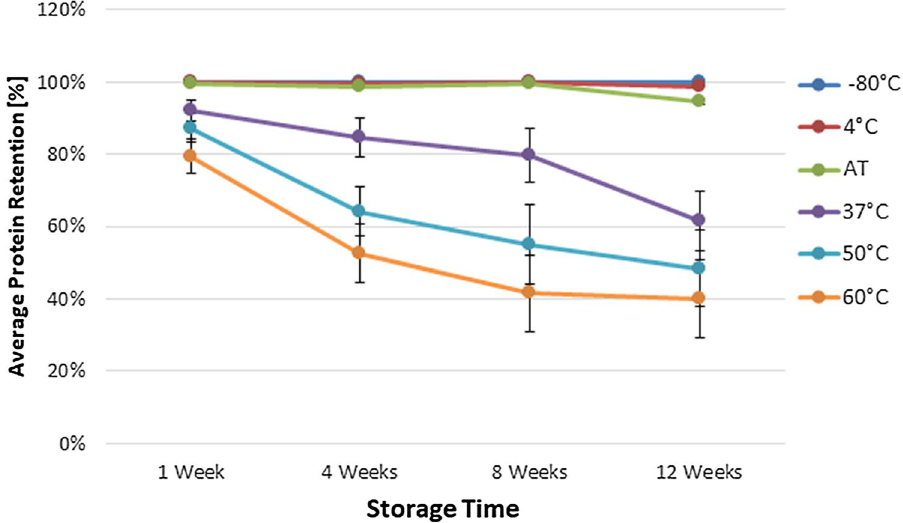
Figure 3. Average stability of 14 proteins in DBS samples over 3 months at varying temperatures. The average retention in the expression levels of 14 relatively serum abundant proteins in DBS samples stored at − 80 °C, 4 °C, ambient temperature (AT), 37 °C, 50 °C, and 60 °C for 1 week, 4 weeks, 8 weeks, and 12 weeks were compared with the expression levels from a corresponding freshly collected DBS sample. Data are expressed as the mean ± SEM.